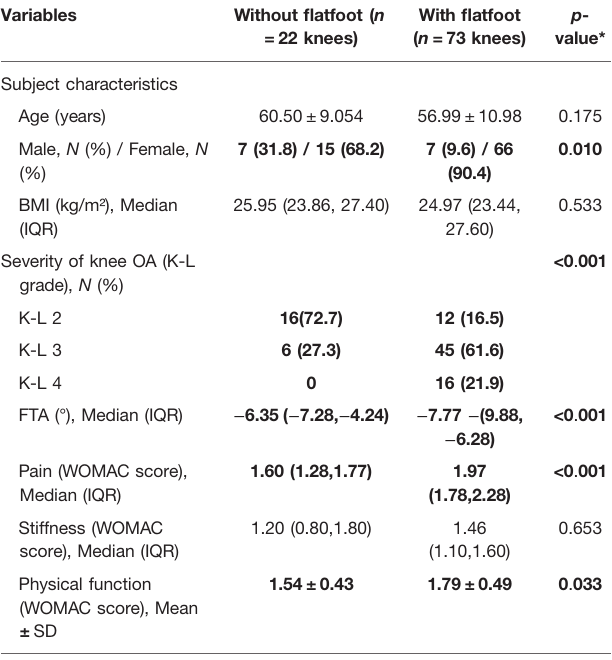
TABLE 2 | Participant -level characteristics of the research knees based on the presence of fl atfoot ( n =95 patients). Variables Without fl atfoot ( n